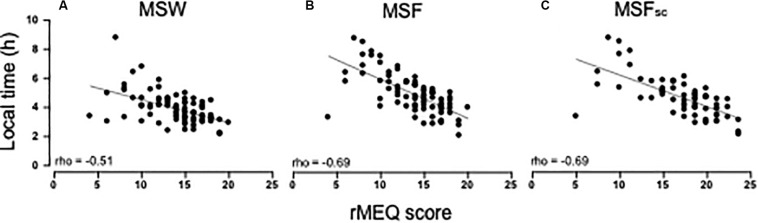
Spearman’s rho correlations between the rMEQ score and MCTQ variables: (A) MSW (mid-sleep on workdays; rho = −0.51; p < 0.001); (B) MSF (mid-sleep on free days; rho = −0.69; p < 0.001); and (C) MSFsc (sleep-corrected mid-sleep on free days; rho = −0.69; p < 0.001). Sample size n = 80 except for MSFsc (n = 62).